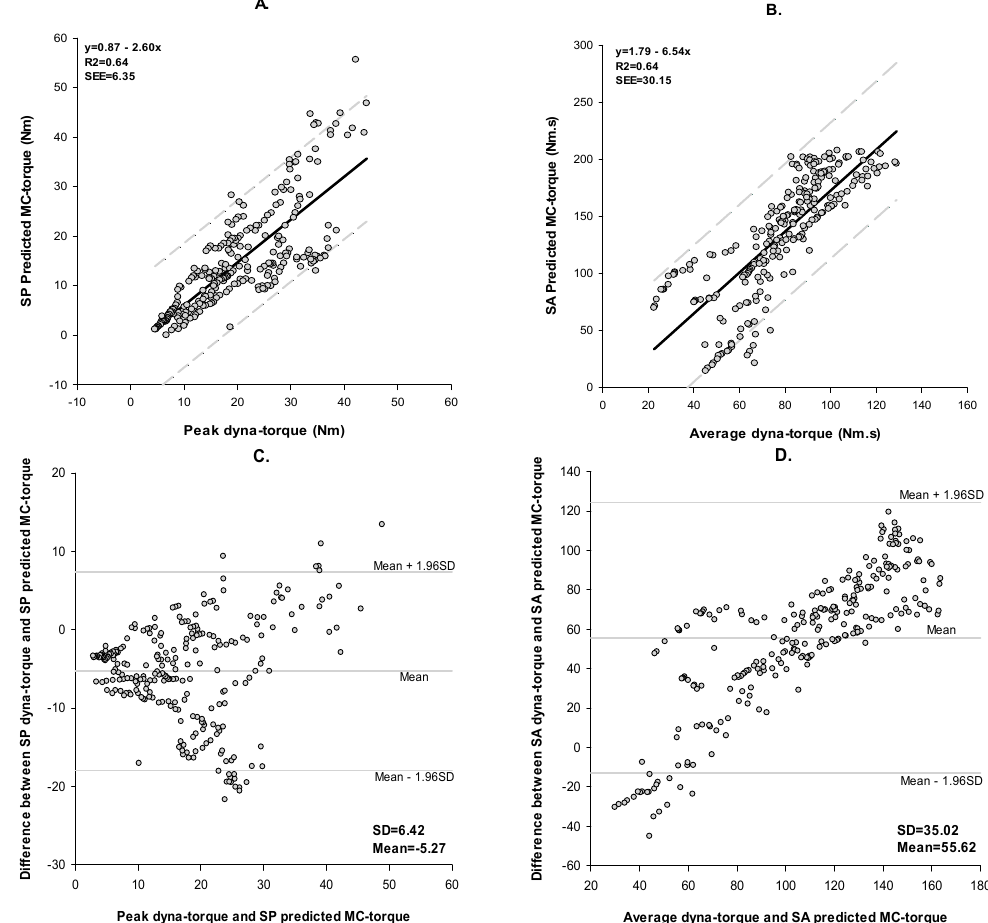
Figure 8. Linear regression and Bland–Altman plots between dyna-torque and the predicted MC torque during the muscle fatigue experiment. ( A ) Linear regression of Peak dyna-torque and the SP predicted MC torque with a 95% confidence band; ( B ) Linear regression of Average dyna-torque and the SA predicted MC torque with a 95% confidence band; ( C ) Bland–Altman plots of Peak dyna-torque and the SP predicted MC torque; ( D ) Bland–Altman plots of Average dyna-torque and the SA-predicted MC torque. Table 3. Muscle performance and muscle fatigue analysis for signal peak and signal average relationships of dyna-torque and predicted MC torque.